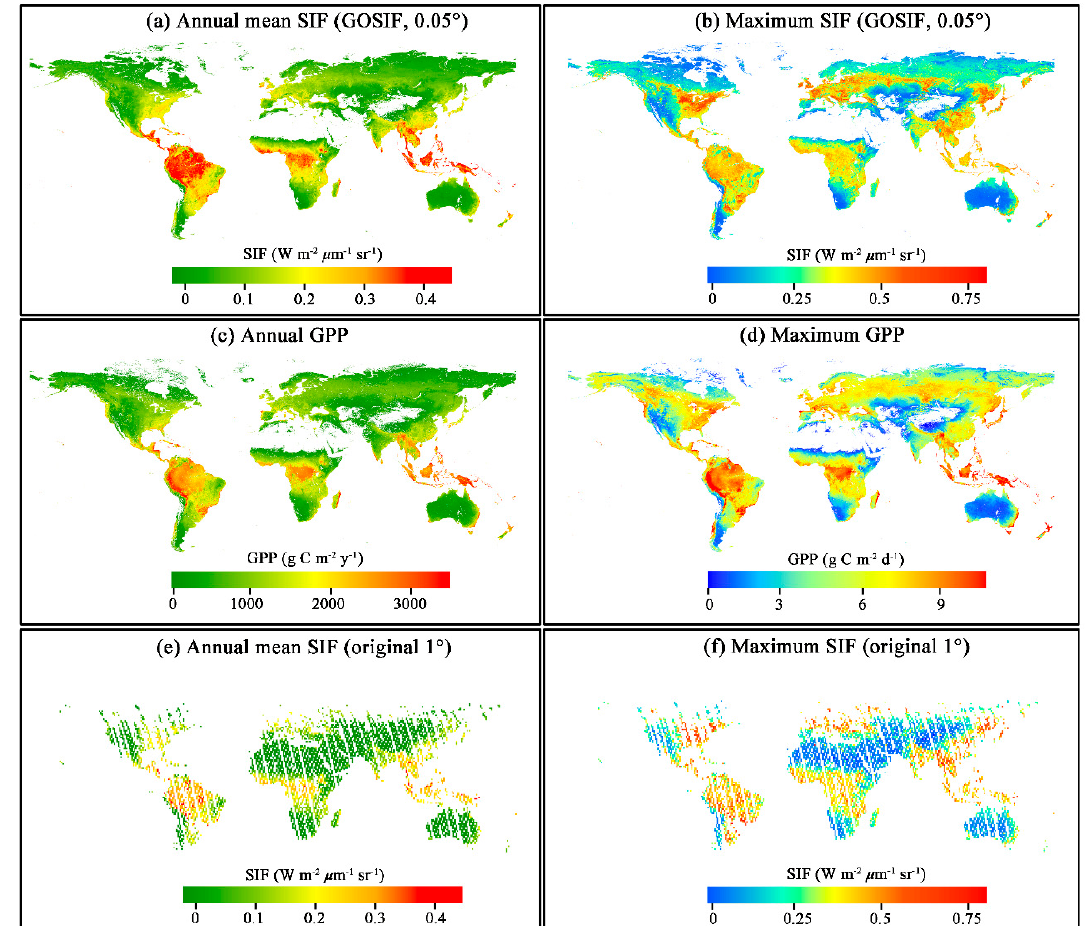
Figure 10. Annual mean and maximum SIF of our GOSIF product (0.05 ◦ , 8-day) and comparison with annual/maximum GPP of the Moderate Resolution Imaging Spectroradiometer (MODIS) GPP product and the annual mean/maximum SIF of the 1 ◦ OCO-2 SIF directly aggregated from discrete OCO-2 SIF soundings in 2015: ( a ) Annual mean new 0.05 ◦ SIF, ( b ) maximum daily new 0.05 ◦ SIF, ( c ) annual MODIS GPP, ( d ) maximum daily MODIS GPP, ( e ) annual mean 1 ◦ SIF, and ( f ) maximum daily 1 ◦ SIF.